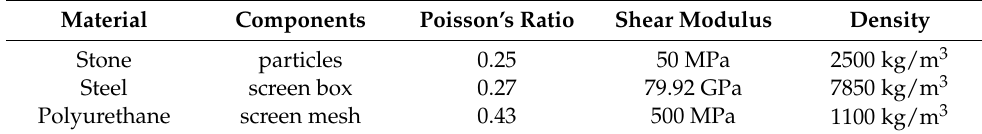
Table 4. Material parameters in the vibration screen model and